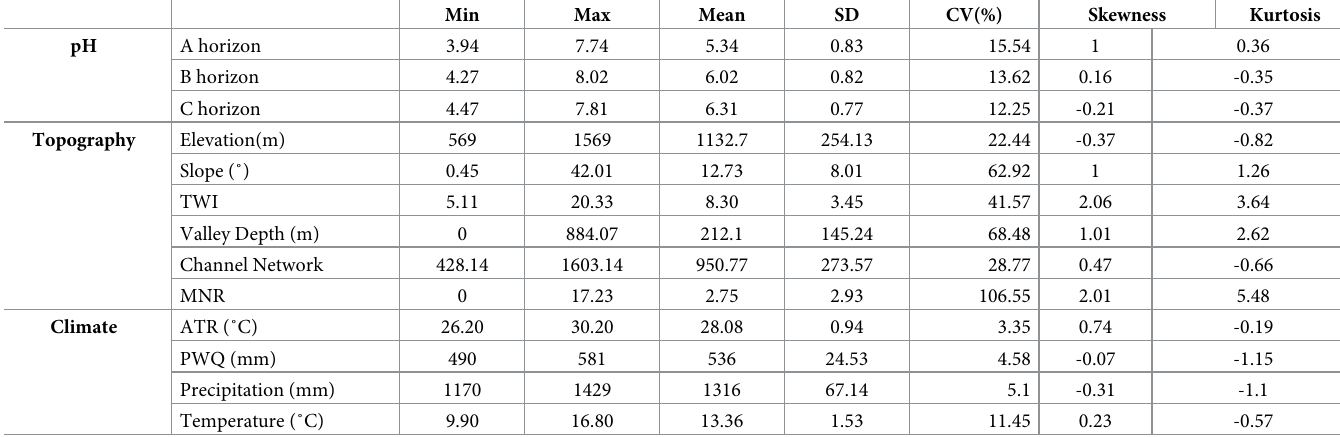
Table 2. Descriptive statistics of soil pH in A, B, and C horizons; topographic indicators; and climate